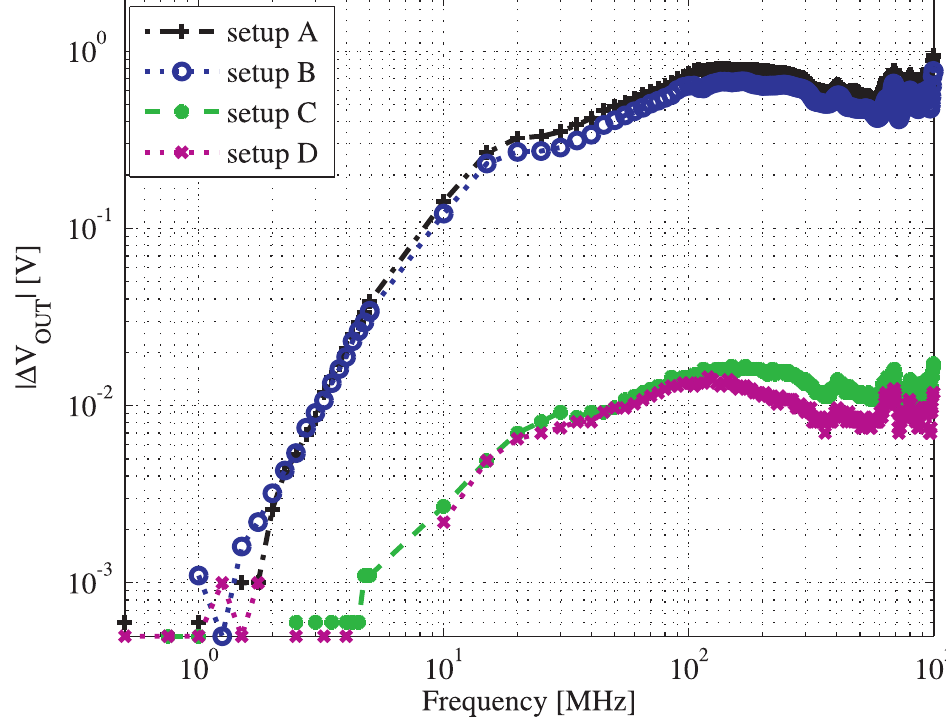
Figure 13. TEM cell immunity measurements at 34 dBm RF power amplitude for different